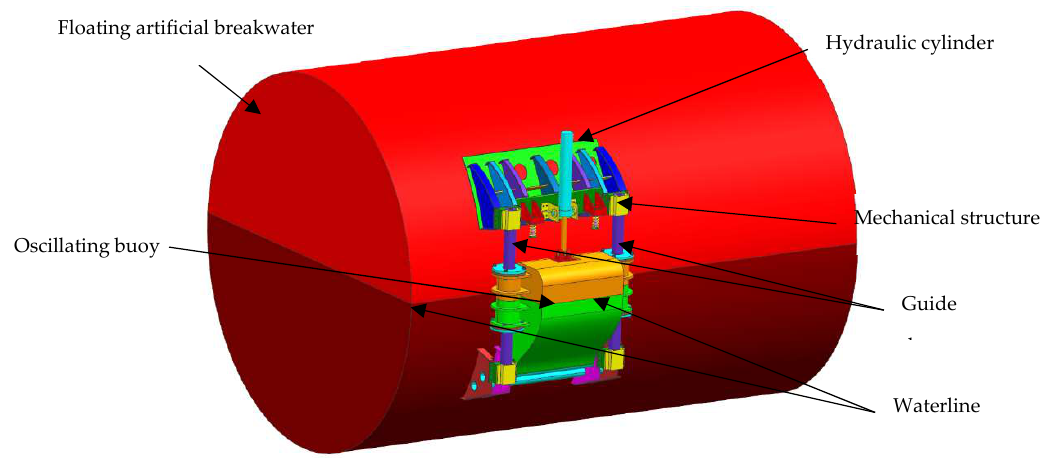
Figure 1. The wave energy converter model on artificial breakwater.